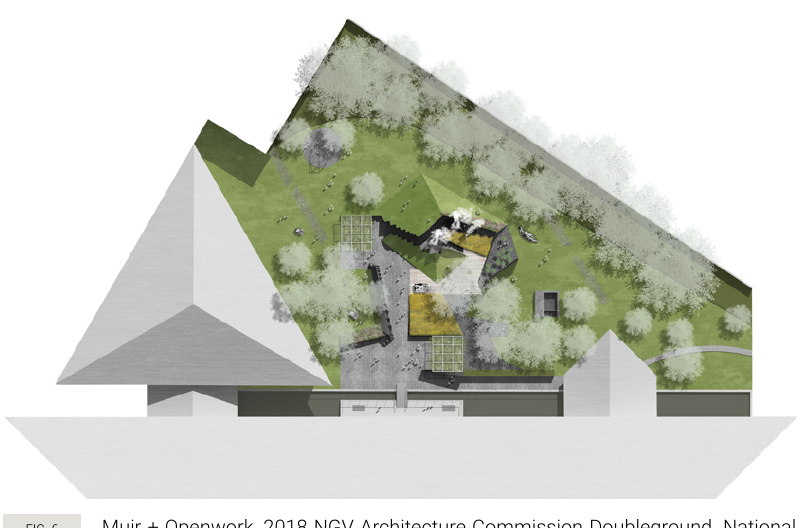
FIG. 6 Muir + Openwork, 2018 NGV Architecture Commission Doubleground. National Gallery of Victoria, Melbourne. Source: Muir + Openwork and